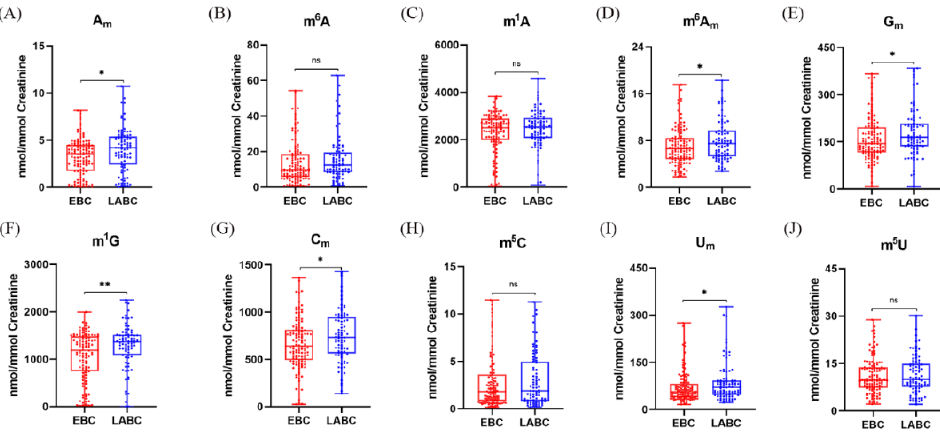
Figure 6. Quantification and statistical analysis results of ( A ) A m , ( B ) m 6 A, ( C ) m 1 A, ( D ) m 6 A m , ( E ) G m , ( F ) m 1 G, ( G ) C m , ( H ) m 5 C, ( I ) U m , and ( J ) m 5 U in urine from EBC and LABC patients. (ns p > 0.05, * p < 0.05, ** p < 0.001).